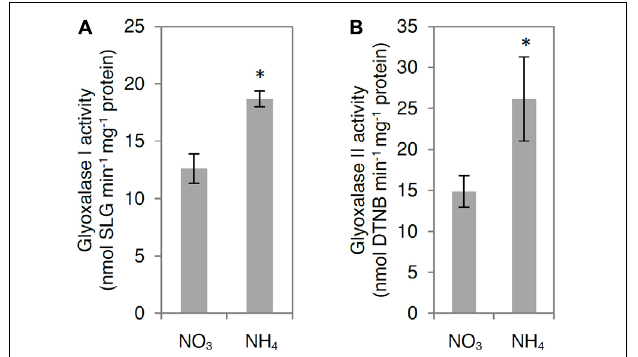
FIGURE 5 | Influence of ammonium (NH 4 + ) nutrition on chloroplast methylglyoxal (MG) detoxification pathway. Activities of (A) glyoxalase I and (B) glyoxalase II in chloroplasts isolated from leaf tissue of nitrate (NO 3 − )-grown and NH 4 + -grown plants. Values are the mean ± standard deviation (SD) of 3 biological and 2 technical replicates. Significant differences ( P ≤ 0.05) between NO 3 − -grown and NH 4 + -grown plants are indicated by an asterisk ( ∗ ).